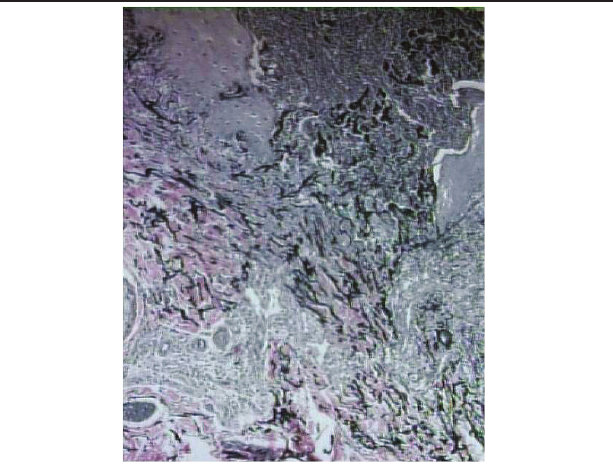
FigurE 5 − Acantotic epidermis and dermis with enlarged elastic tissue adjacent to the transepidermal elimination channel area. Elastic fibers and necrotic material being eliminated (Verhoeff, 100×)